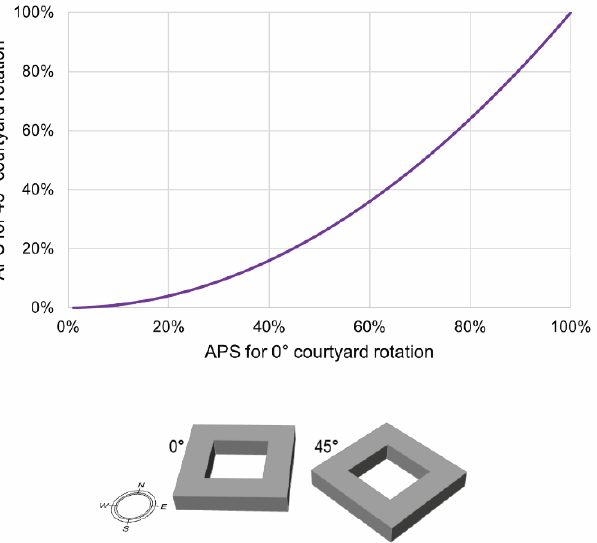
Figure 6. The graph presents a universal relationship between the values of the area of permanent shadow (APS) metric depending on the orientation of a square closed building courtyard. The 0° orientation has facades facing the cardinal directions.